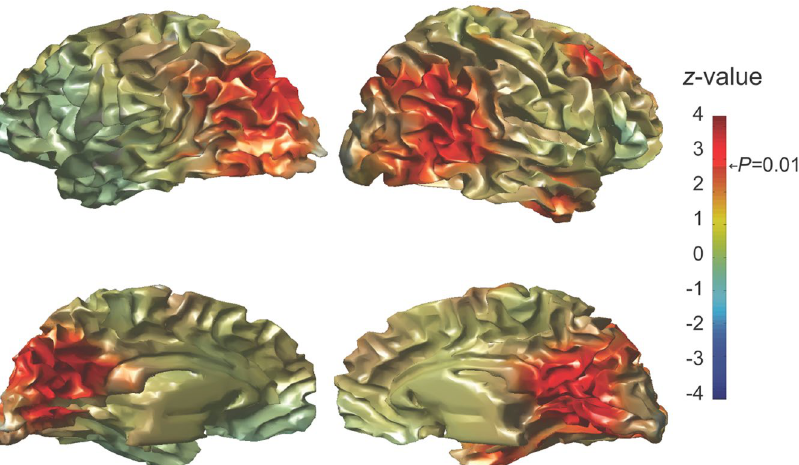
Figure 3. Beamformer-estimated voxels where alpha power correlated with the duration of individual perceptual representations. The estimated alpha power in each of the voxels was used as regressor of the perceptual duration, using a LMEM to return a z -value. The regression was calculated for each voxel of the brain on a 10 mm spaced grid of a template MRI, distributed with SPM8 and segmented 81 . For illustration purposes, the z -values are projected onto the cortical surface and the z -values are thresholded at 2.326, corresponding to a one-sided p -value = 0.01. The regions showing the strongest association are located in the cortical regions around the parieto-occipital